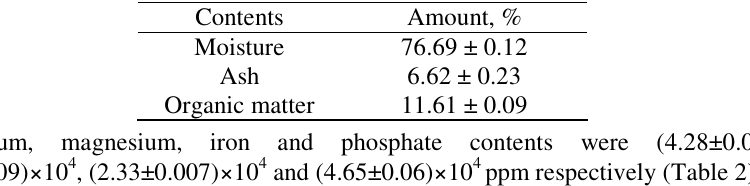
Table 1. Quantitative measure of moisture, ash and organic matter of Datura metel